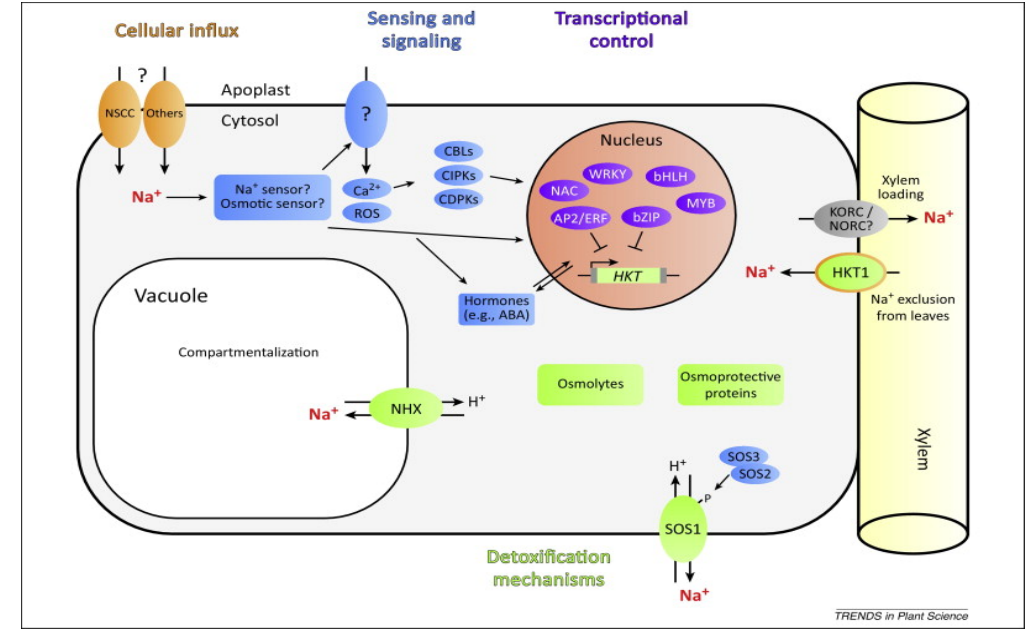
Figure 5. Overview of cellular Na + transport mechanisms and the salt stress response network in plant root cells. Na + (depicted in red) enters the cell via NSCCs and other membrane transporters (cellular Na + -influx mechanisms highlighted in orange). Inside the cell, Na + is identified. This activates Ca 2 + , ROS, and hormone signaling cascades. CBLs, CIPKs, and CDPKs are part of the Ca 2 + -signaling pathway (sensing and signaling components highlighted in blue), which can alter the global transcriptional profile of the plant (transcription factor families in the nucleus depicted in purple; an AP2 / ERF and a bZIP transcription factor that negatively regulate HKT gene expression are shown as an example). Ultimately, these early signaling pathways result in expression and activation of cellular detoxification mechanisms, including HKT, NHX, and the SOS Na + transport mechanisms, as well as osmotic protection strategies (cellular detoxification mechanisms highlighted in light green). Furthermore, the Na + distribution in the plant is regulated in a tissue-specific manner by unloading of Na + from the xylem. Abbreviations: NSCCs, nonselective cation channels; ROS, reactive oxygen species; CDPKs, calcium-dependent protein kinases; CBLs, calcineurin B-like proteins; CIPKs, CBL-interacting protein kinases; AP2 / ERF, APETALA2 / ETHYLENE RESPONSE FACTOR; bZIP, basic leucine zipper; NHX, Na + / H +